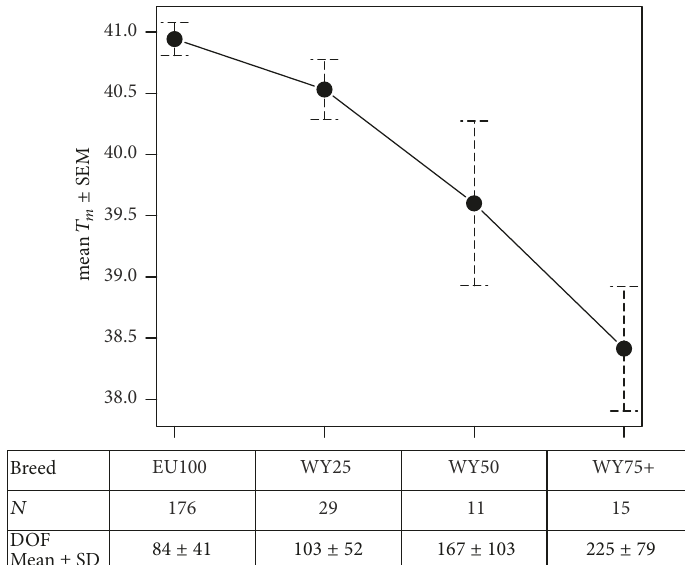
Figure 2: 𝑇 𝑚 decreases with feeding and increasing proportion of Wagyu ancestry . 𝑇 𝑚 of subcutaneous fat samples over the loin of a mix of breeds and crossbreeds including Simmental, Gelbvieh, Angus, Dexter, and Wagyu. 176 samples (EU100) came from 100% European breeds fed for an average of 81 days. WY25, WY50, and WY75+ samples had 25%, 50%, and 75–100% Wagyu ancestry, respectively. There were 29 samples of WY25, 14 samples of WY50, and 11 samples of WY75+ with average days on feed of 103, 167, and 225,